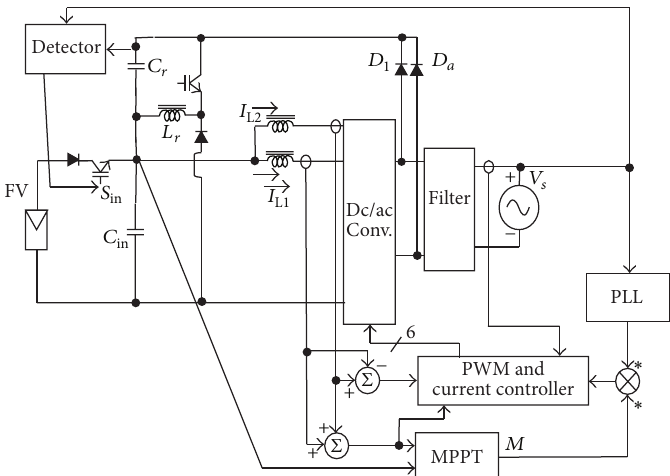
Figure 7: Controller of the system.